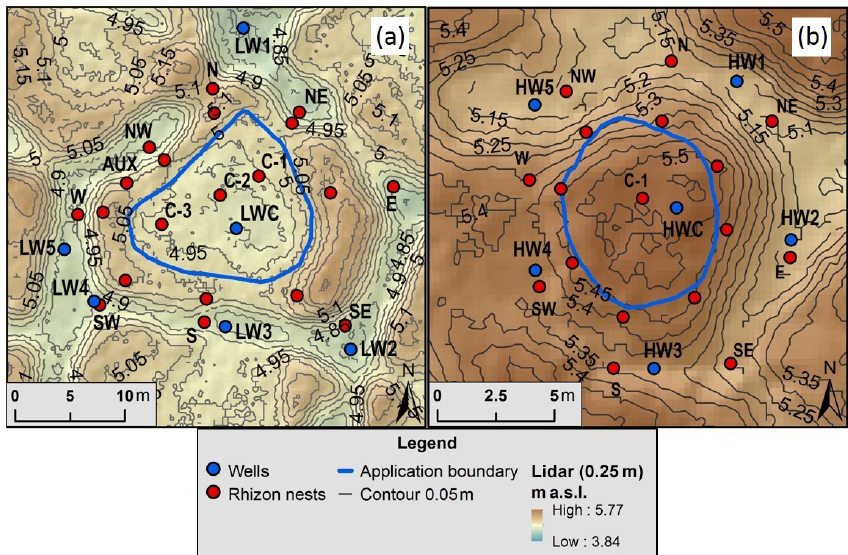
Figure 3. Digital elevation model for the low-centered (a) and high-centered (b) polygons. Red dots represent locations of sampler nests and blue dots represent locations of observation wells. Blue circle indicates area of tracer application and encompasses the polygon center: 167.4m 2 for the low-centered polygon and 41.6m 2 for the high-centered polygon. Note scales are different for the two